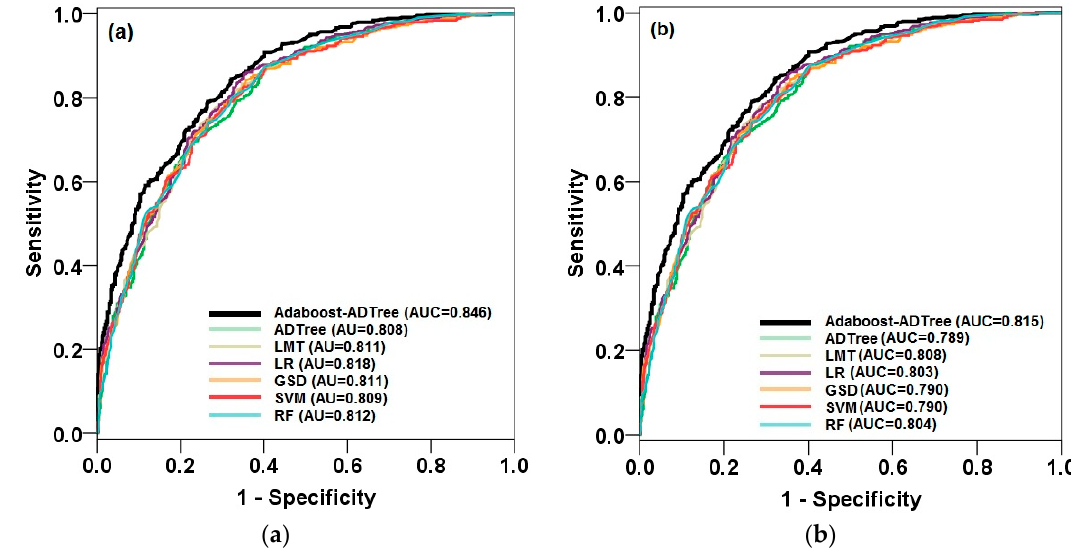
Figure 5. Area under the ROC curve (AUROC) of the seven models for groundwater potential mapping (GSPM) using training ( a ) and validation ( b ) datasets.